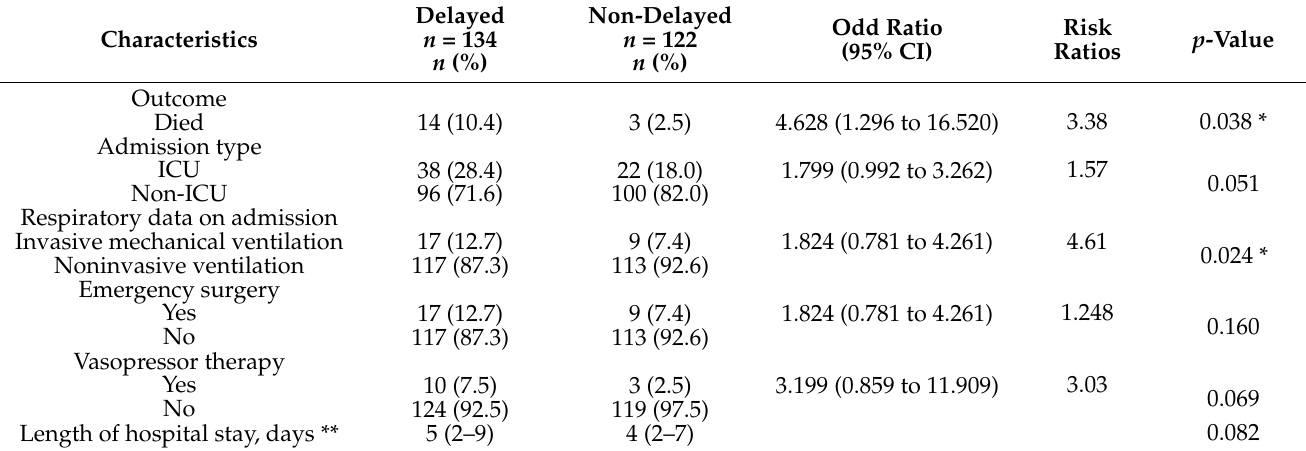
Table 3. Outcomes of delayed and non-delayed